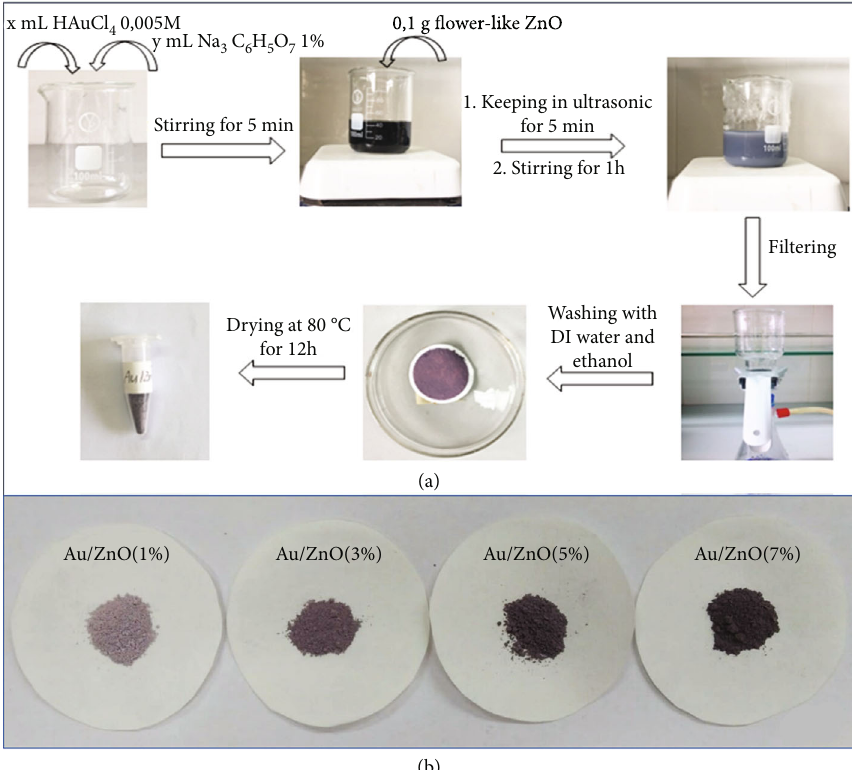
Figure 1: (a) The synthesis procedure of Au/ZnO composite and (b) the color change of Au/ZnO composites with the di ff erence of